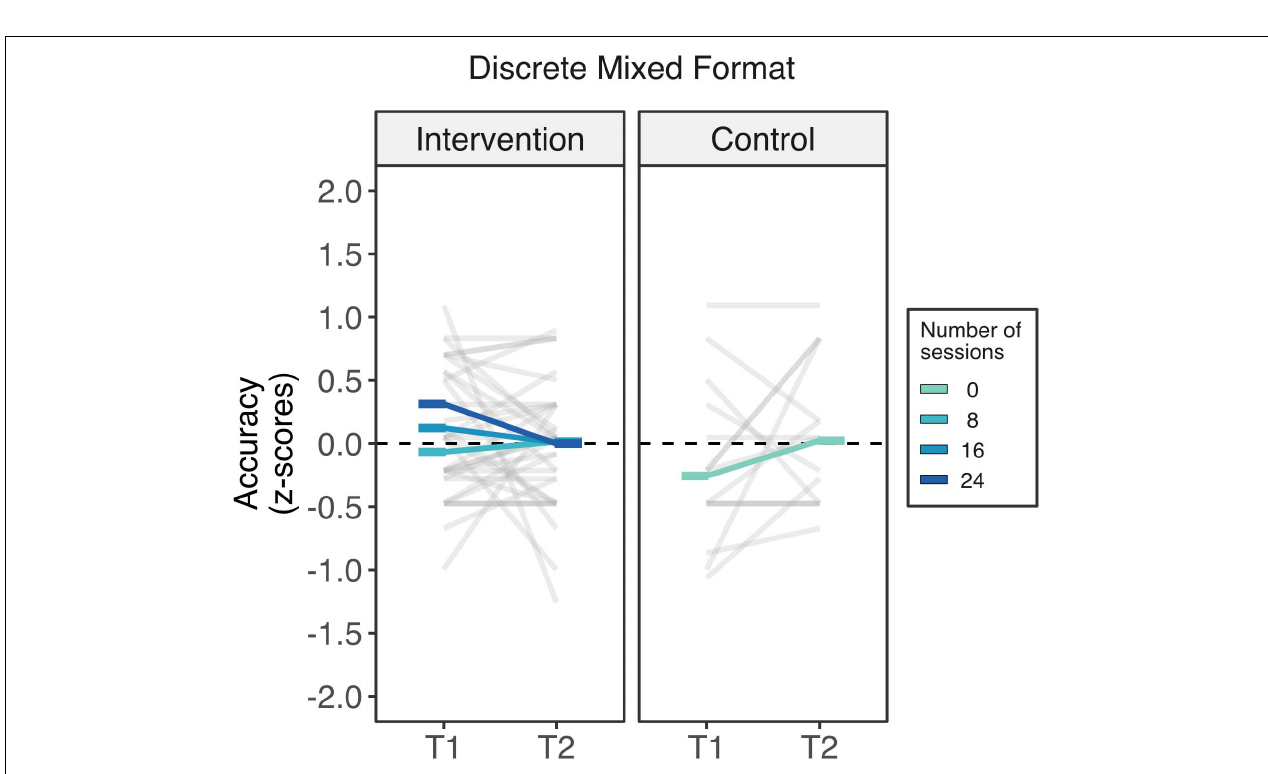
FIGURE 5 | Intervention outcomes in the non-symbolic discrete mixed format of the Spinners task across groups. Changes in the discrete mixed format from time 1 to time 2 did not vary by attendance to the intervention. Rods represents the estimated marginal means across different number of sessions of attendance from 0 sessions (control group) to 24 sessions (darkest